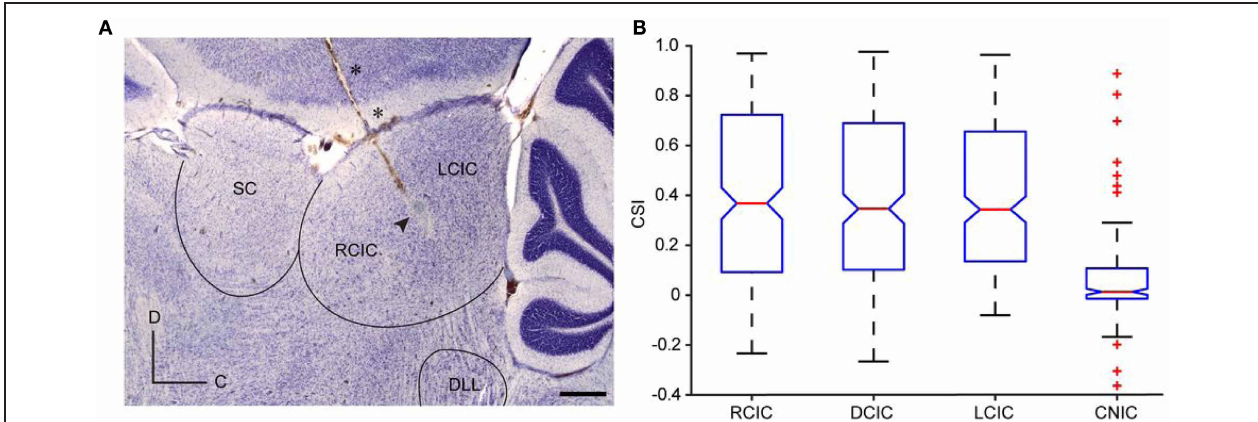
FIGURE 2 | Anatomical location of SSA in the IC. (A) Photomicrography showing a sagittal section of the IC with a typical electrode track (asterisks) and the electrolytic lesion generated (arrowhead). Scale bar = 500 µ m. C, caudal; D, dorsal. (B) Box plot with the median value (red line) of CSI sorted by anatomic regions. The blue